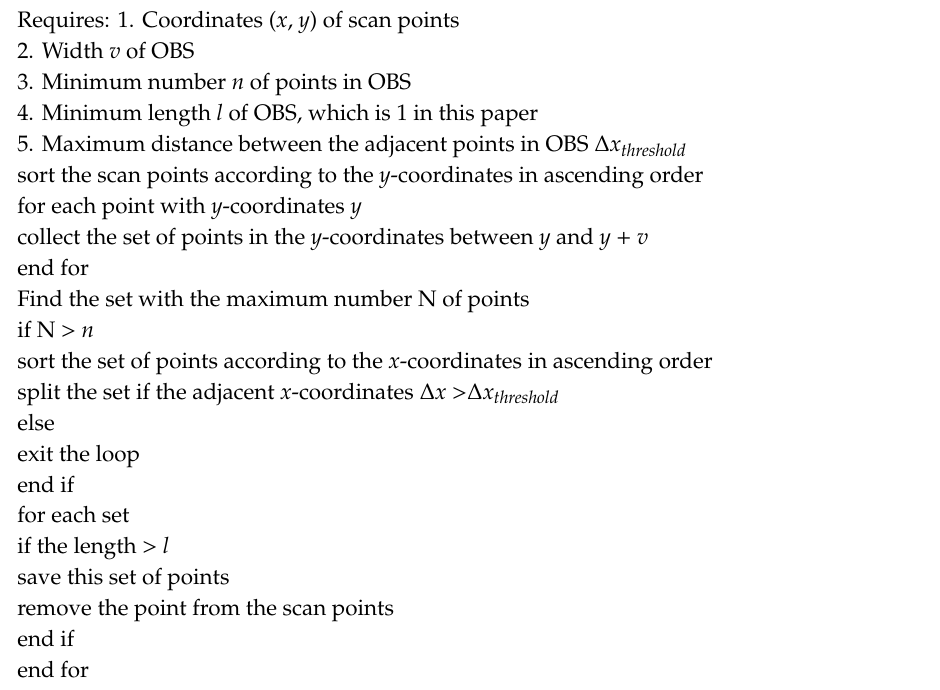
Algorithm 1 : Pseudo-code of OBS extraction, where OBSs are parallel to x coordinate